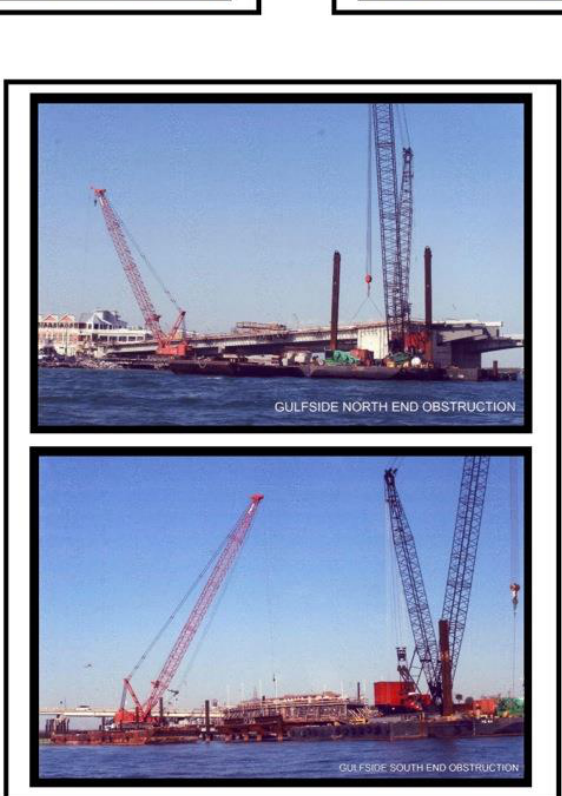
Figure 1. Construction